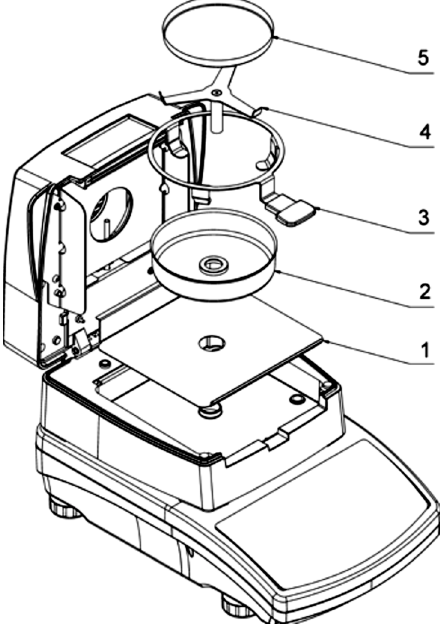
Figure 1. MA.R infrared (IR) dryer and moisture analyzer. 1. Drying chamber base insert. 2. Drying pan shield. 3. Drying pan handle. 4. Cross-shaped holder. 5. Disposable pan.